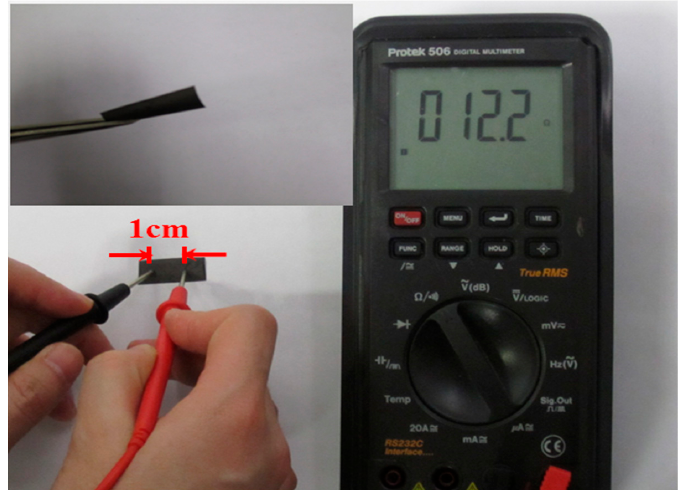
Figure 7. conductive testing of the printed nickel patterns after CRS process, the insert is the flexibility of patterns on the kapton substrate.